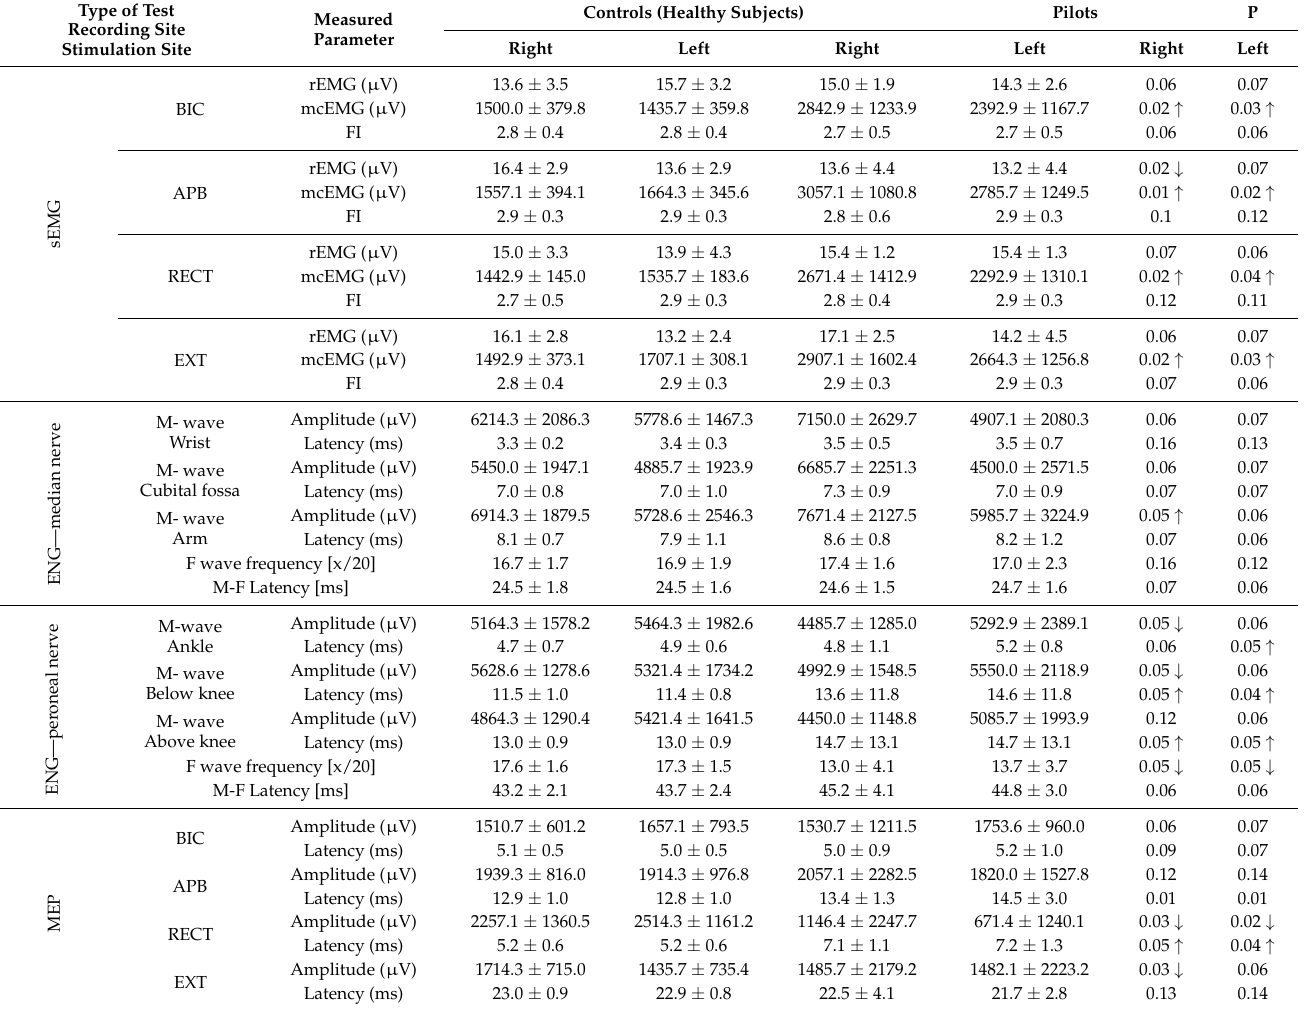
Table 3. Comparison of the results of neurophysiological tests in healthy people (N = 15) and pilots (N = 15). The mean values with standard deviations are presented. P—significant differences are marked bold. Arrow heads indicate increase ( ↑ ) or decrease ( ↓ ) the parameters recorded in pilots in comparison to the